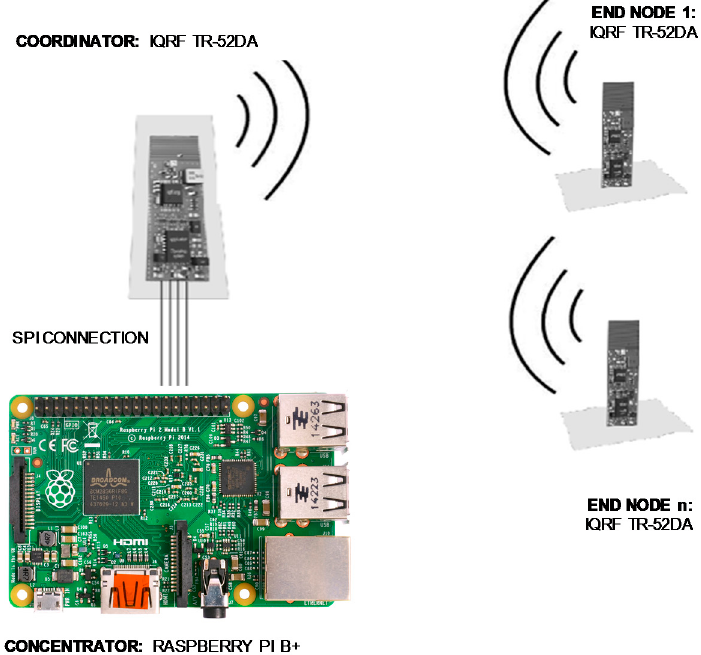
Figure 2. Implementation of the IoT gateway architecture showing the hardware modules.